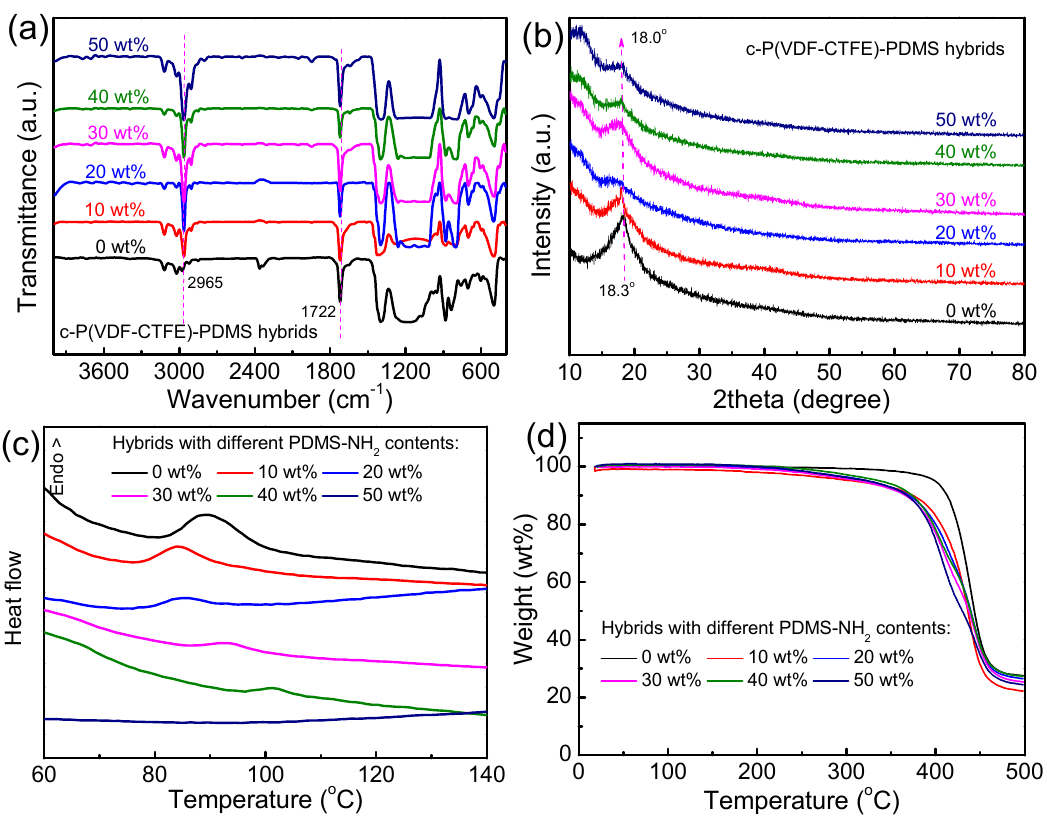
Figure 3. ( a ) FT-IR spectra, ( b ) WAXD patterns, ( c ) DSC curves, and ( d ) TGA result of the hybrids with various PDMS-NH 2 contents.